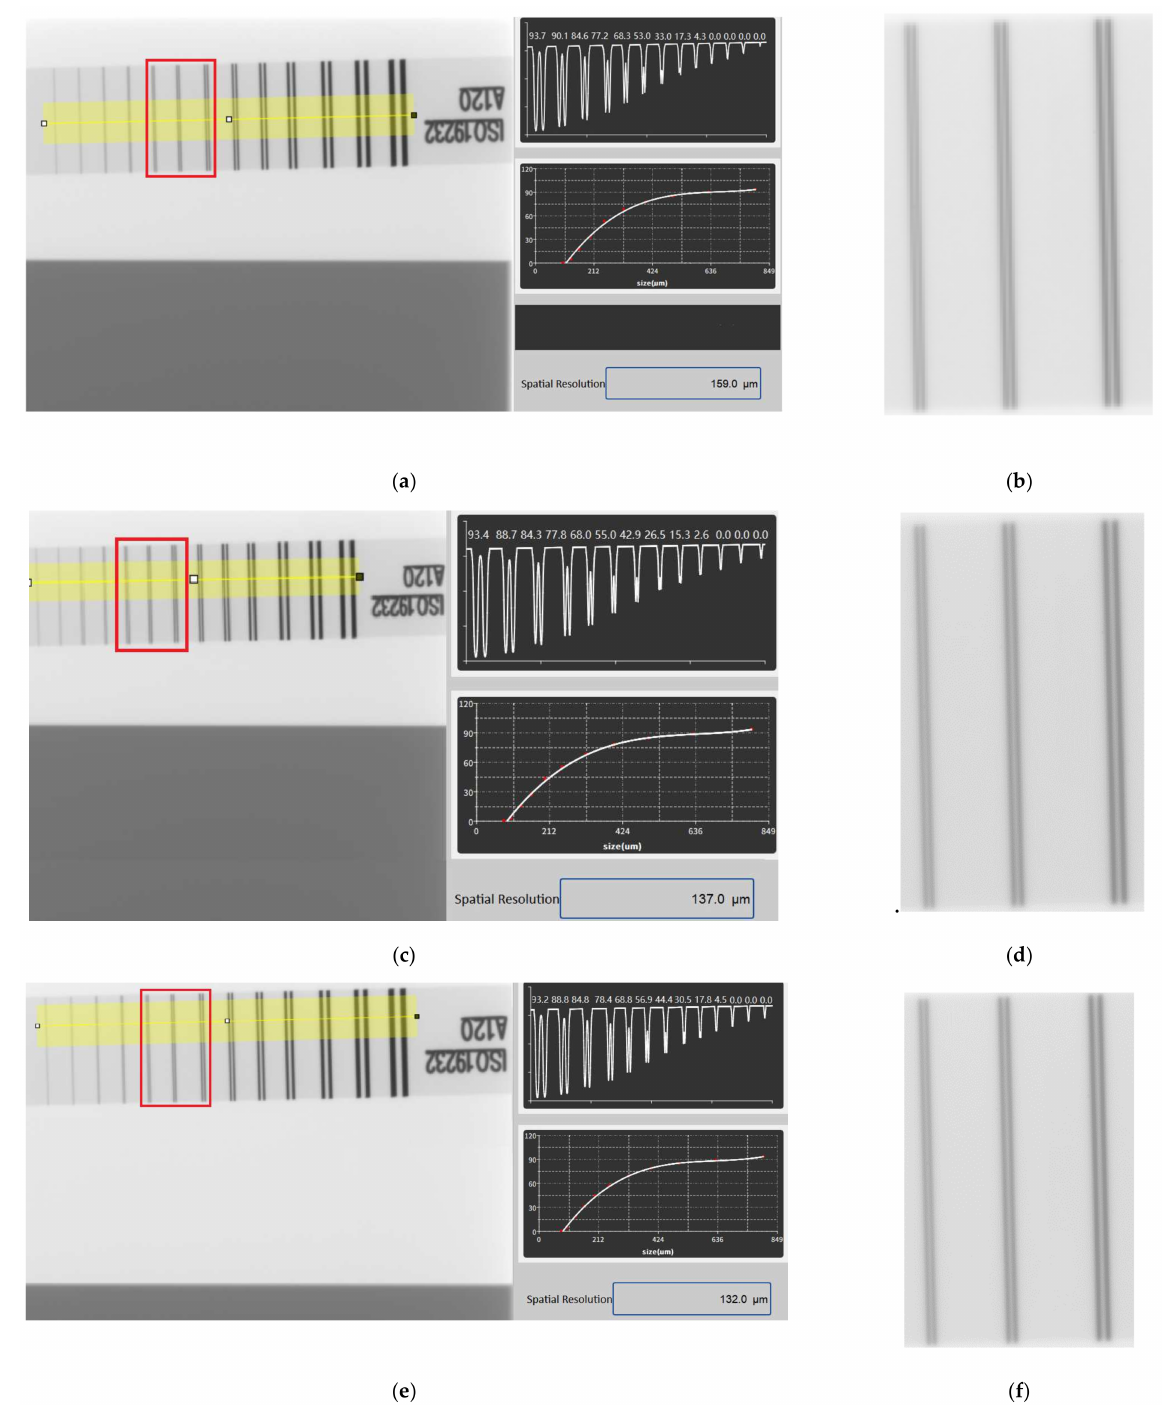
Figure 11. The image spatial resolution SR image of the detector: ( a ) original image, ( c ) 2 × 2 sub-pixel b shift image, ( e ) 4 × 4 sub-pixel shift image; ( b , d , f ) are the corresponding local enlargement images of the boxed areas of the duplex wire